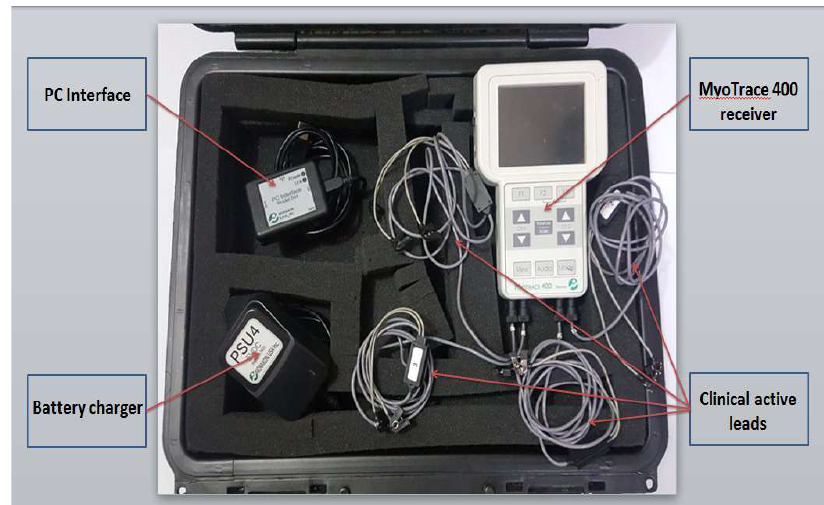
Fig.10. Noraxon EMG measurements device and its